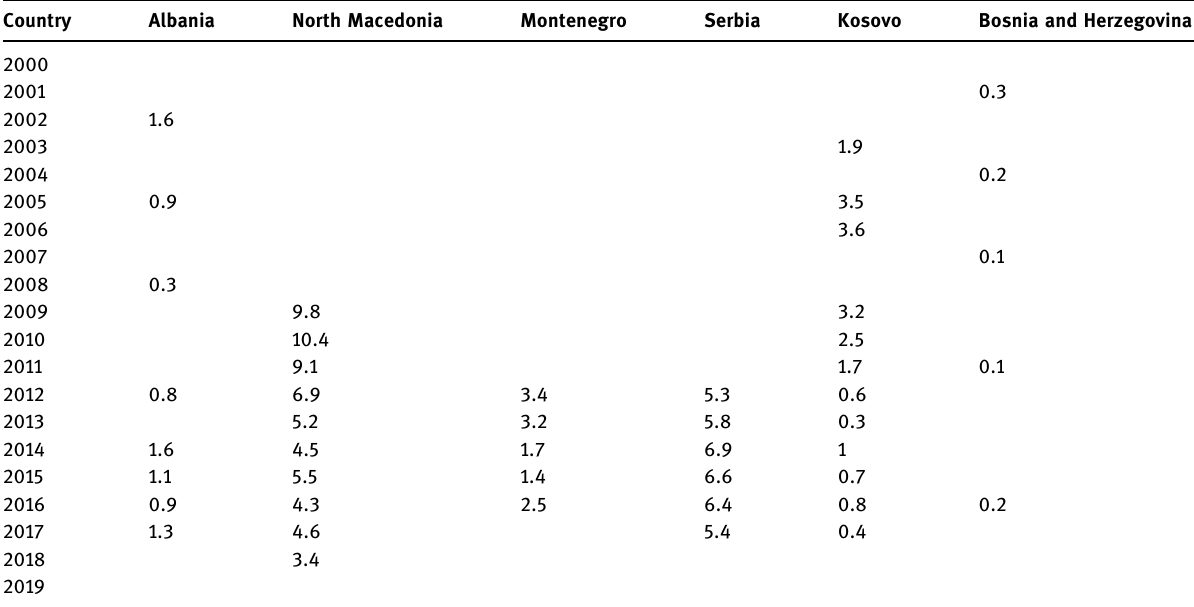
Country Albania North Macedonia Montenegro